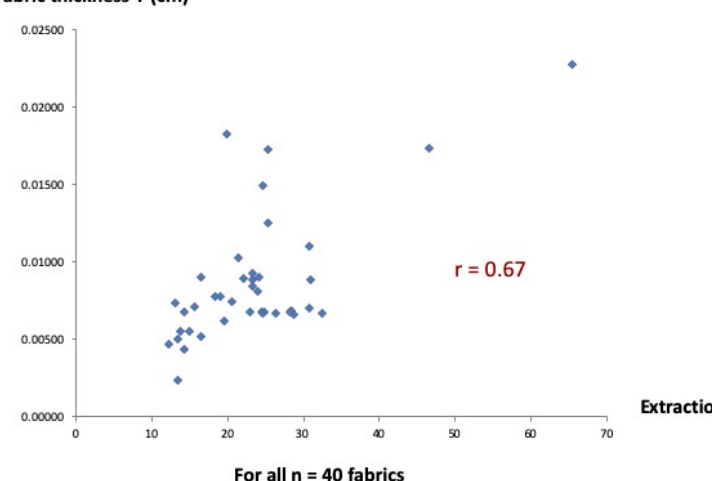
Figure 2. Fabric weight vs. extraction energy.